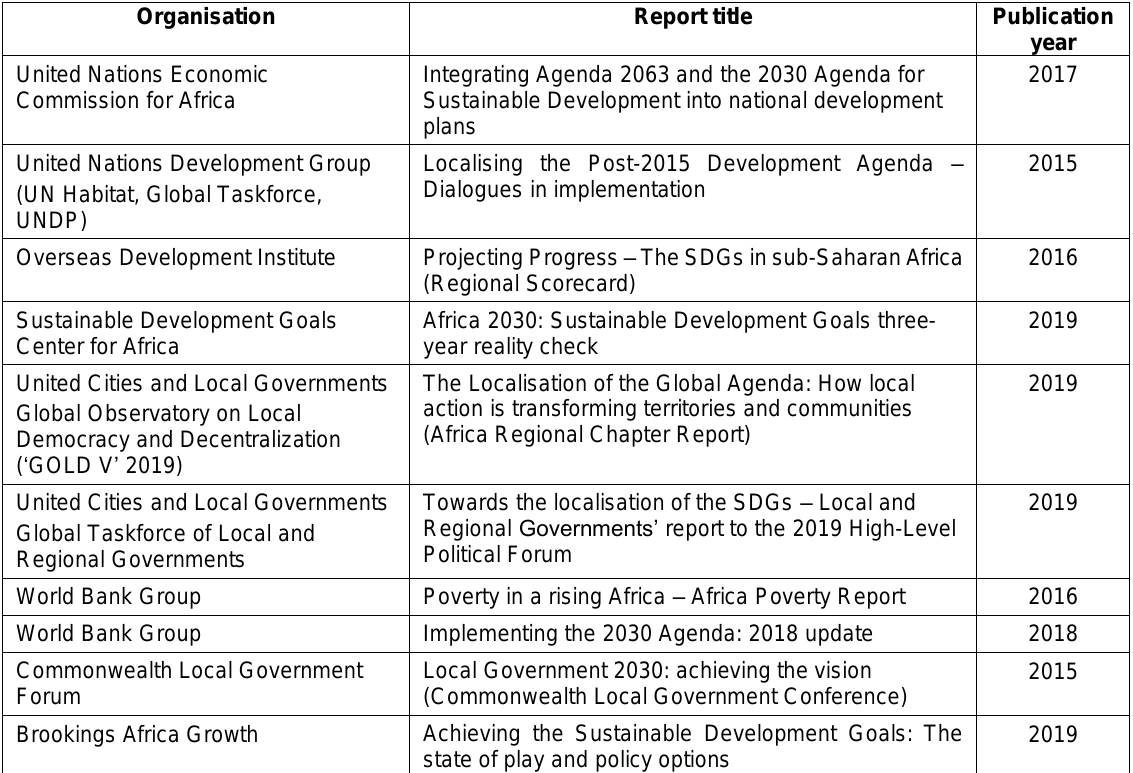
Table 1: Summary of reports analysed